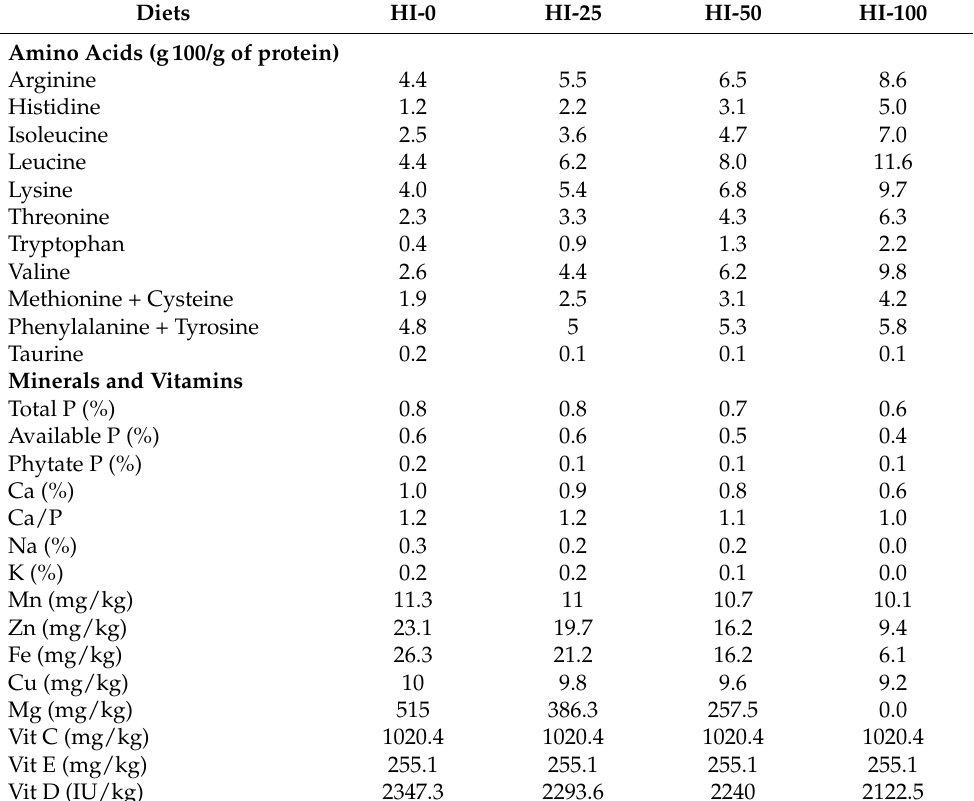
Table 2. Amino acid, mineral, vitamin, and fatty acid composition of experimental